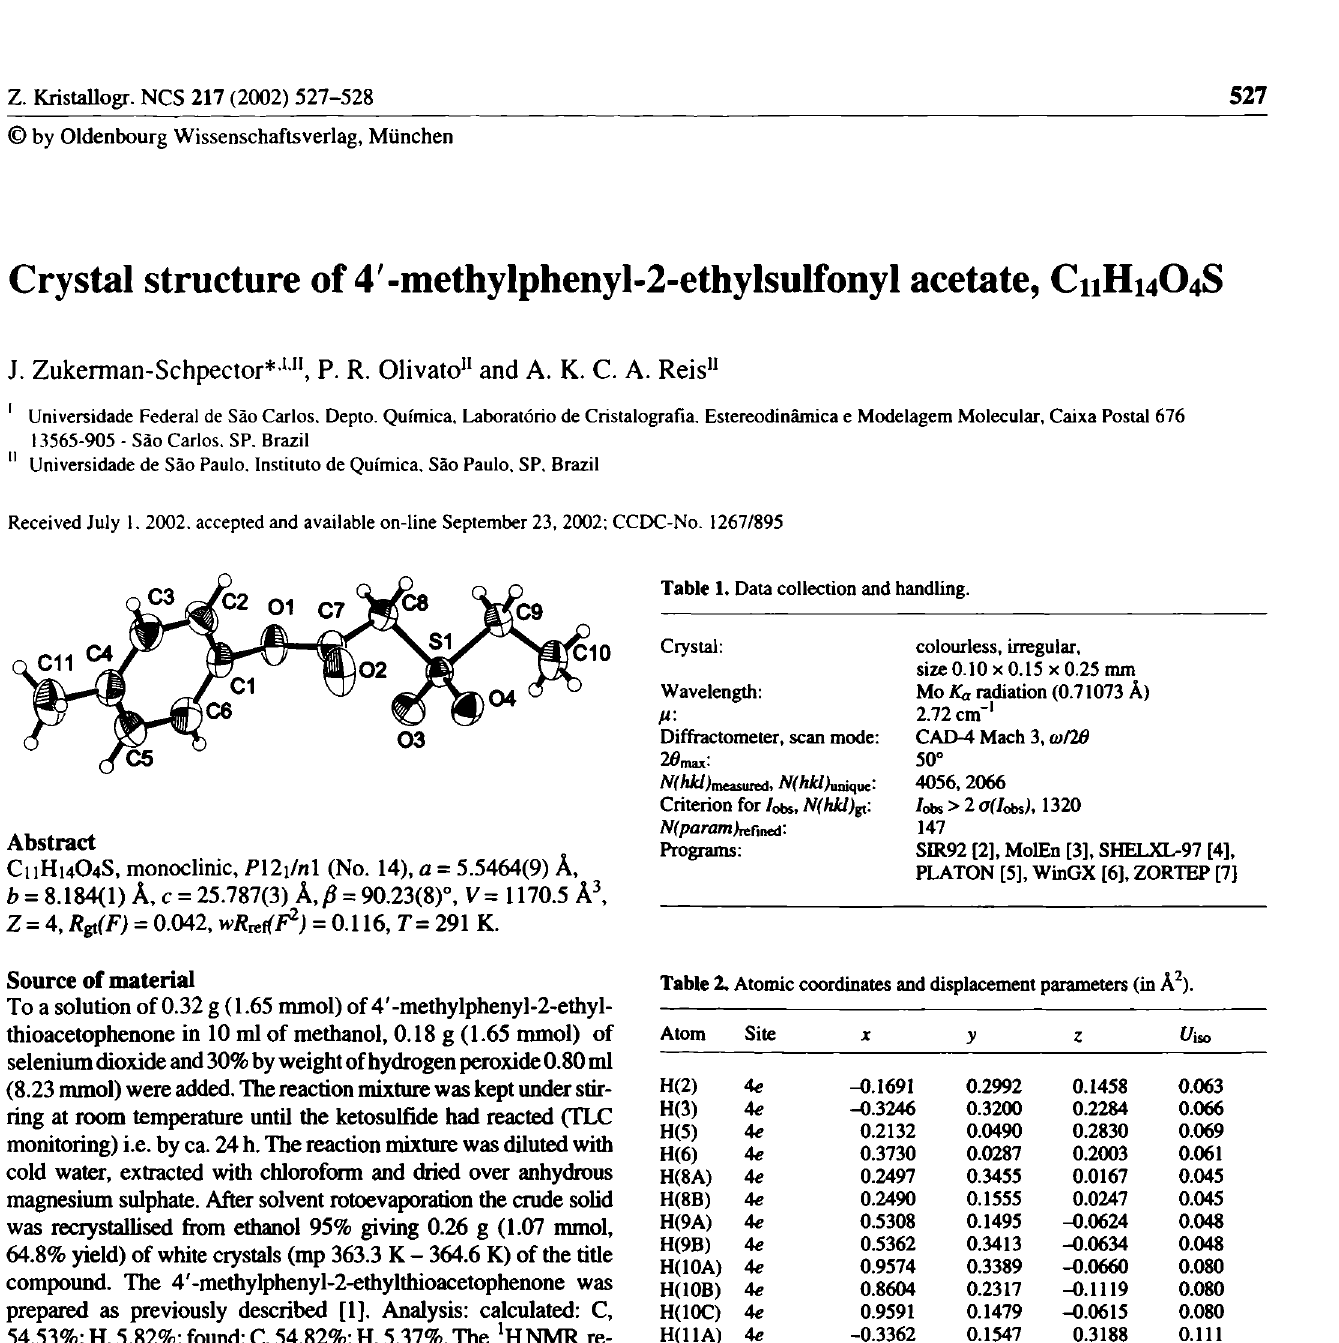
Table 2. Atomic coordinates and displacement parameters (in Â 2